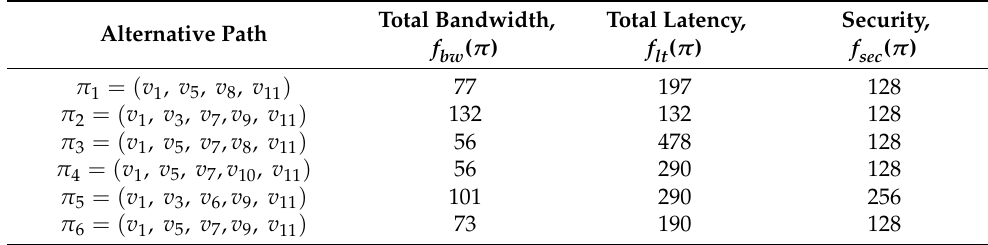
Table 2. The Pareto set of the alternative paths for Graph A. Alternative